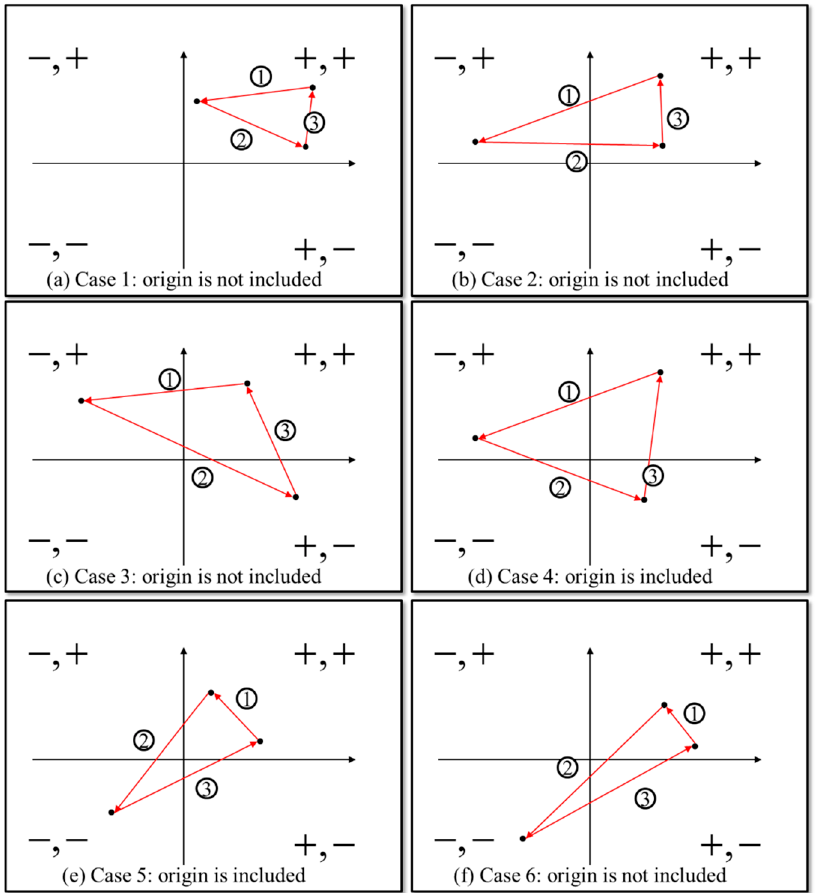
Figure 5. Judgment of test points for six cases. ( a – c , f ) Cases 1, 2, 3, and 6, origin is not included; ( d , e ) Cases 4 and 5, origin is included in the triangular area.